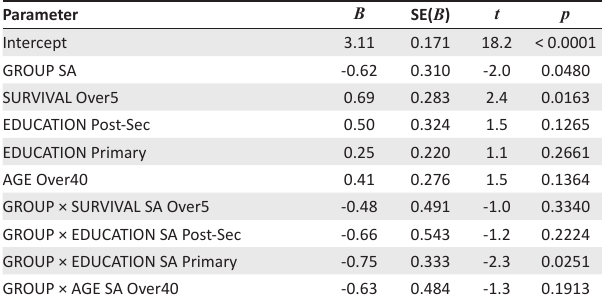
TABLE 7: Parameter estimates for two-way interaction analysis of variance model of business and product visibility. Parameter